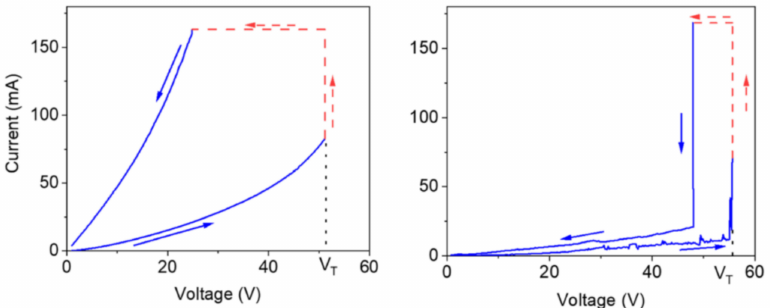
Figure 9. Electrical switching behavior observed in a pressed powder pellet of melanin as published by the Santanto group. On the left the behavior of an apparent dry sample is shown and on the right a wet sample is shown. As can be seen, as the voltage is increased up to a threshold voltage V T , the material enters a low resistance phase. Reprinted with permission from M. Raeli, A. Gouda, J. Bellemare et al.,